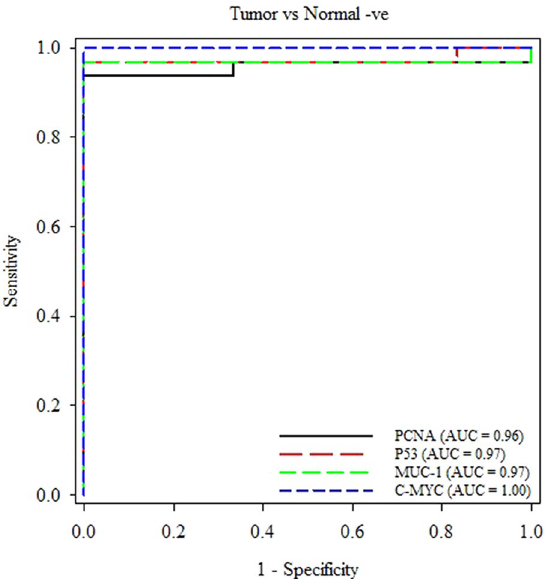
Figure 4. Comparison of receiver operating characteristic (ROC) curves of four different AAbs in mammary tumor detection. Figure was prepared using SigmaPlot v14.0 (Systat Software, San Jose, CA, USA).